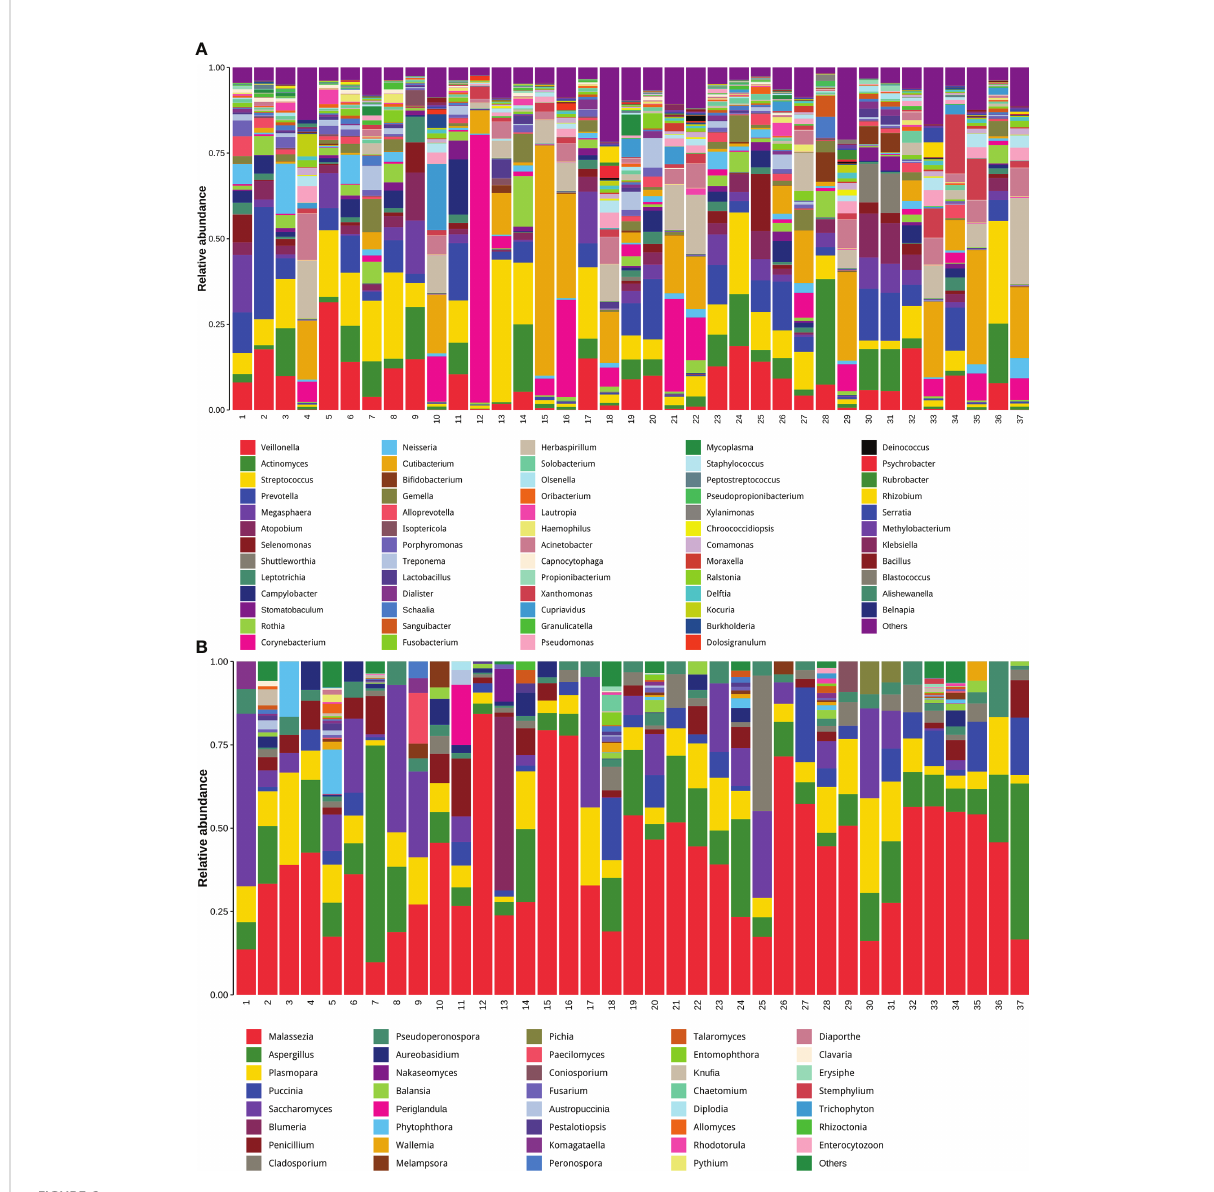
FIGURE 6 Untargeted host-removed mNGS accurately revealed the compositions of both the bacterial and fungal and bacterial communities. The bacterial (A) and fungal (B) with abundance greater than 1% were presented, and less than 1% of the total abundance were combined into the “ Other <1% ”